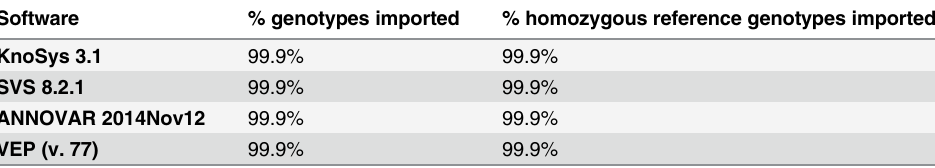
Table 6. Compatibility of the eVCF file format with different variation analysis